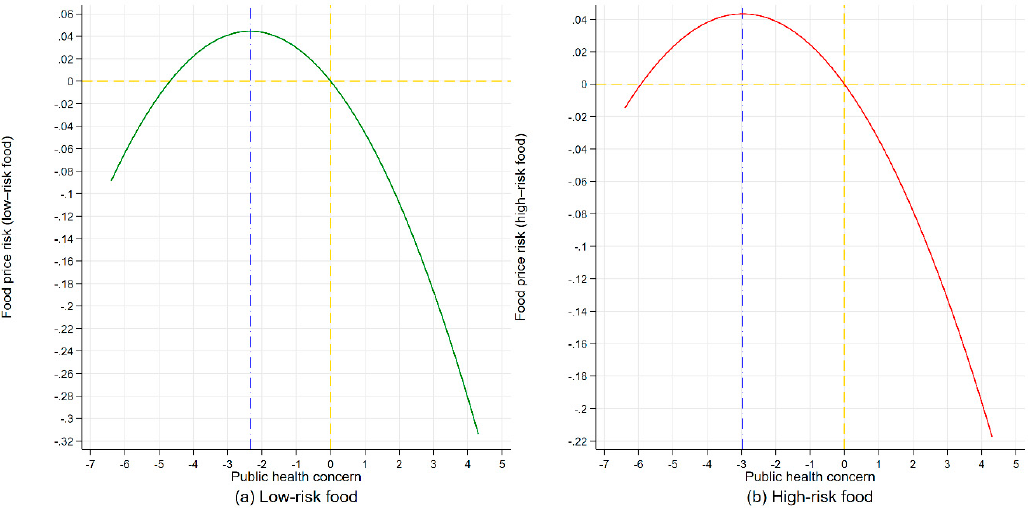
Figure 4. ( a ) Plot of marginal effect of public health concern on low-risk food price risk from column (4) of Table 4; and ( b ) Plot of marginal effect of public health concern on lnhrfp from column (8) of Table 4. Dot-dashed blue line denotes lnphcb turning point reference line. Dashed gold line denotes 0 reference line. Source: Authors’ original calculations using Stata.